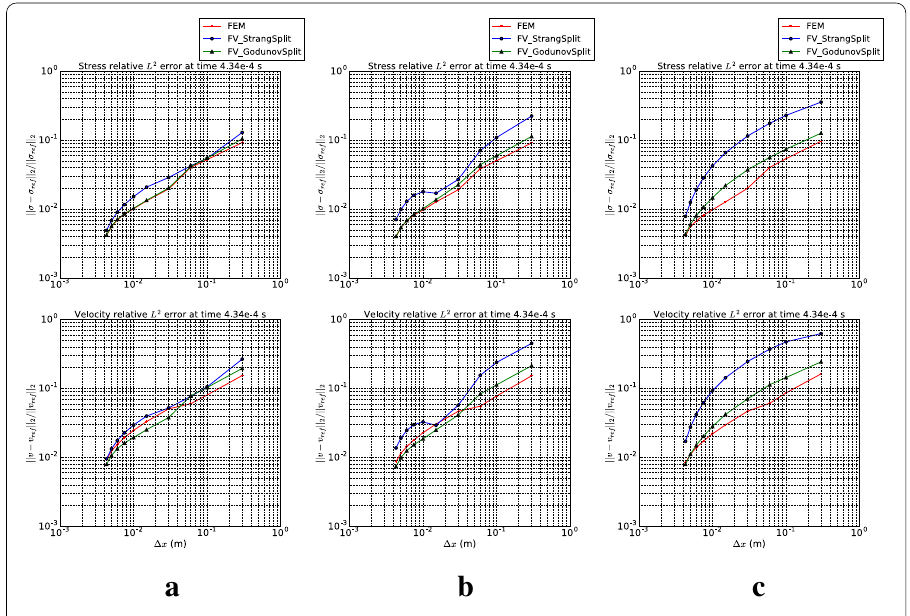
Fig. 8 Relative L 2 errors of the stress and velocity computed at time 4 . 34 × 10 − 4 s with a CFL number set at one for a discontinuous profile of the initial velocity field. Comparison is performed for three values of the relaxation parameter τ , with the FEM, the Strang and Godunov splitting finite volume solutions. a τ = 10 − 4 s. b τ = 4 . 8 × 10 − 6 s. c τ = 10 − 7